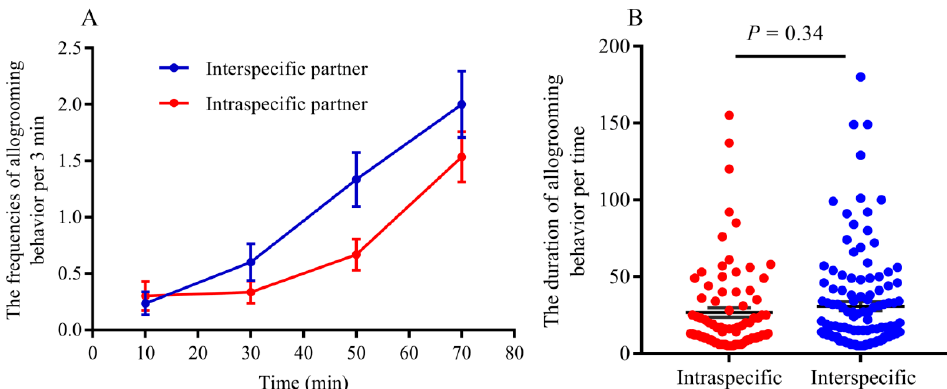
Figure 3. ( A ): The frequencies of allogrooming in intraspecific and interspecific partners. ( B ): The duration of allogrooming behavior per time (unit: min). The allogrooming frequencies in interspecific partners is significantly higher than those in intraspecific partners (GLMM: F = 6.39, p = 0.012), but there were no significant differences in the duration of allogrooming between them ( t = − 0.96, p = 0.34). •